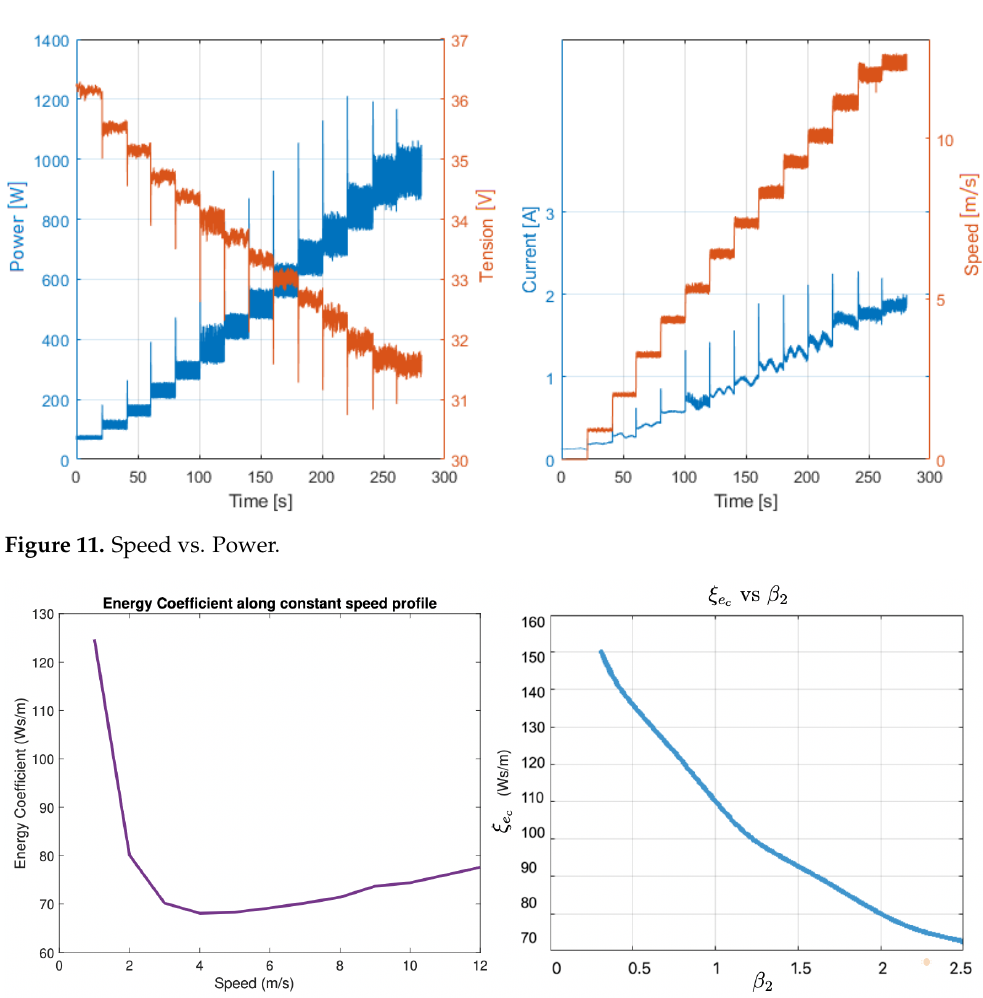
Figure 12. Energy coefficient